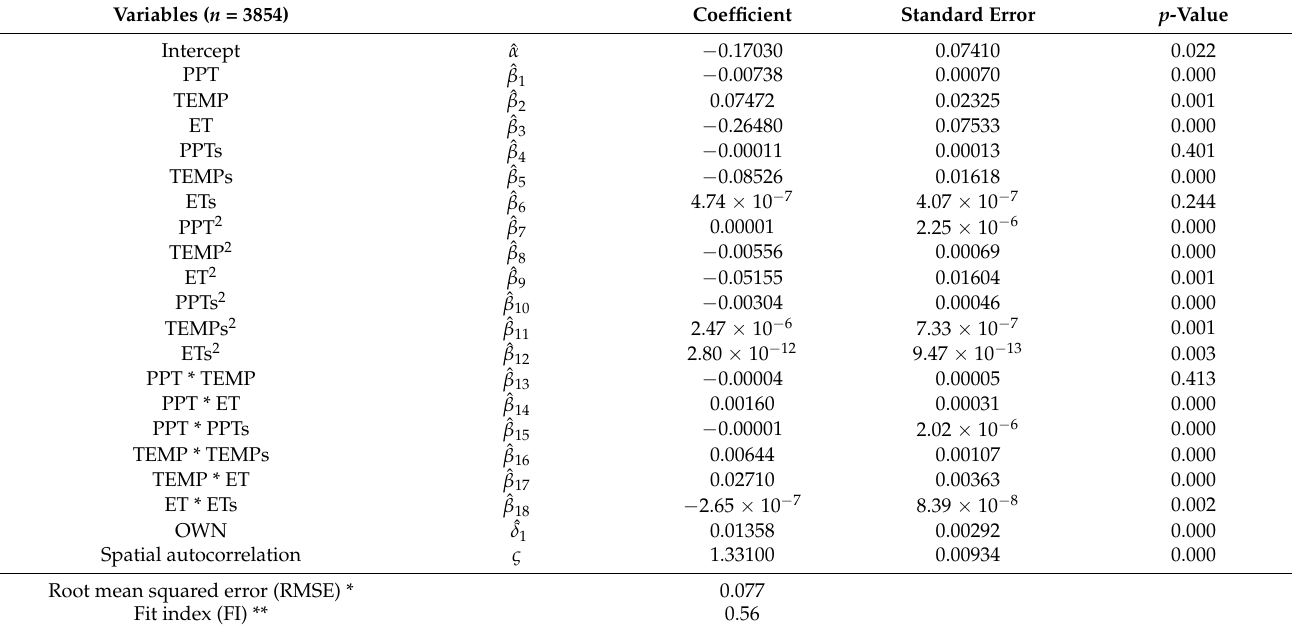
Table 3. Fire risk model coefficients to estimate the wildfire probability in an ecoregion of a county of the continental United States.